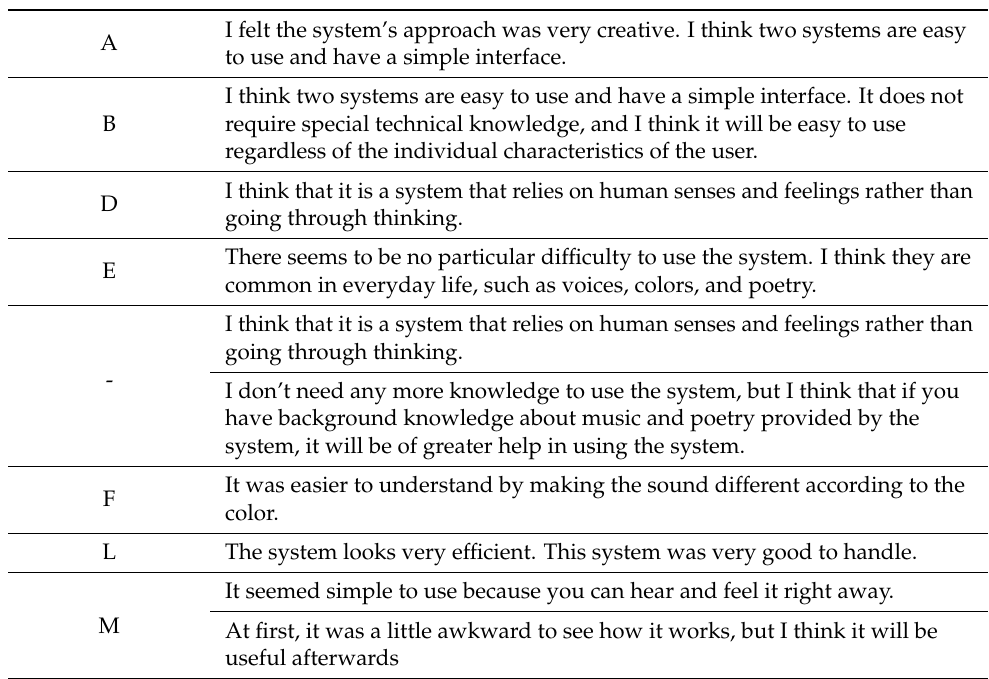
Table 10. Positive user feedbacks from the System Usability Scale